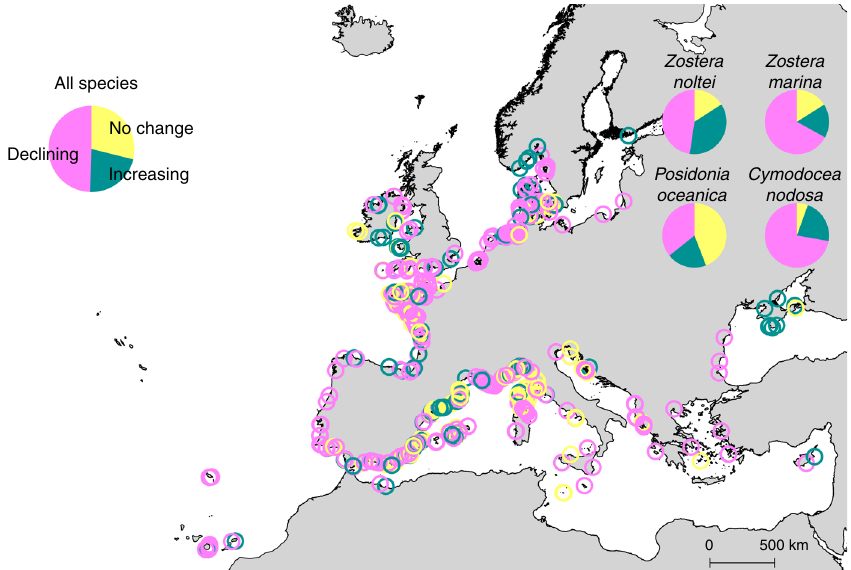
Fig. 1 Distribution of compiled seagrass sites in Europe and their trajectories. Seagrass sites in Europe showing no change (yellow circles, n = 213), increase (green circles, n = 160), and decline (magenta circles, n = 364) trajectories based on the available time series reports between 1869 and 2016, thus corresponding to different time windows. Pie charts show the overall and species-speci fi c frequencies of trajectories. Number of sites showing decline, increase, and no change trajectories are, respectively: 128, 72, and 158 for Posidonia oceanica ; 146, 37, and 35 for Zostera marina ; 39, 12, and 3 for Cymodocea nodosa